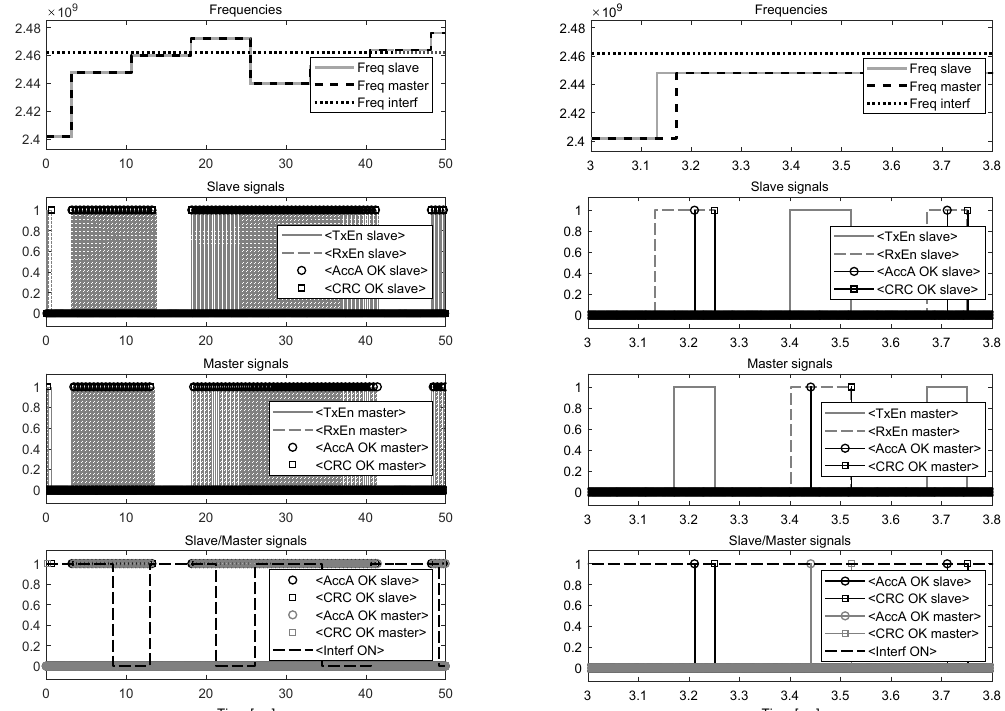
Figure 17. Internal signals of the master1 (M1), slave1 (S1) and 802.11b interferer (model M 2S1 ) from 0 to 50 ms (on the left) and from 3 to 3.8 ms (on the right)—the left side shows interruptions in the data transmission between M1 and S1 when the interferer is turned on and its channel frequency is close to the frequencies used by M1 and S1, while the right side shows the exchange of the first data packets between M1 and S1 after the connection has been